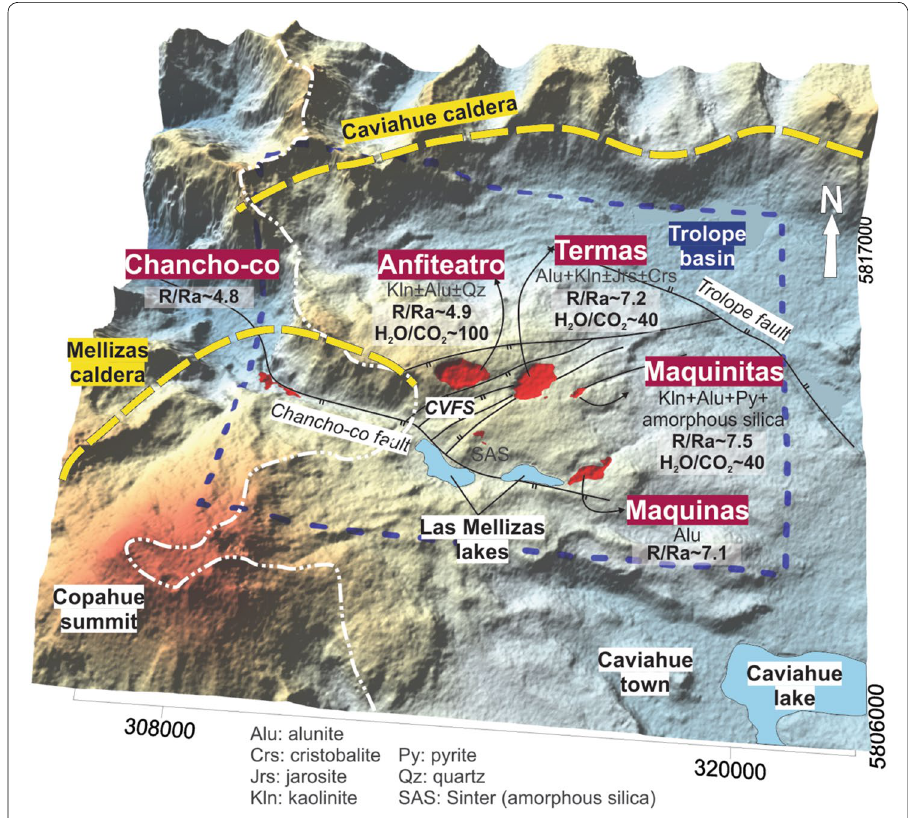
Fig. 4 Chemical features of the geothermal manifestations (red patches) at Copahue geothermal field overlying a 3D view of the topography (blue–red colormap; Shuttle Radar Topography Mission data). Chemical and isotopic data from Chiodini et al. (2015) and Roulleau et al. (2016). Hydrothermal soil composition from Mas et al.